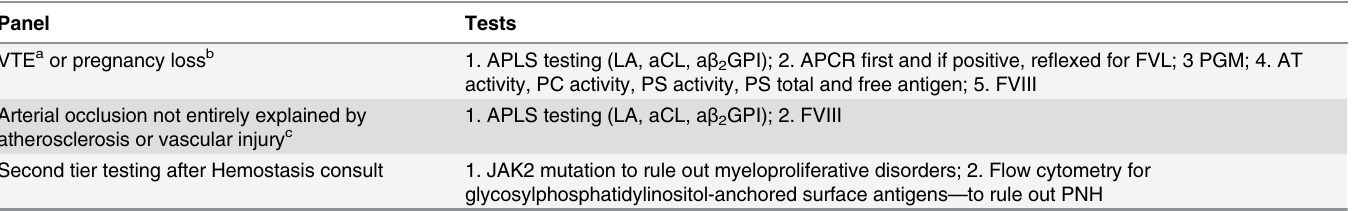
Table 3. Thrombophilia Testing Panels in the outpatient